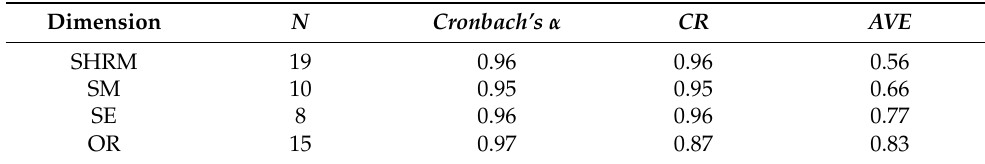
Table 1. Reliability test results for each variable.